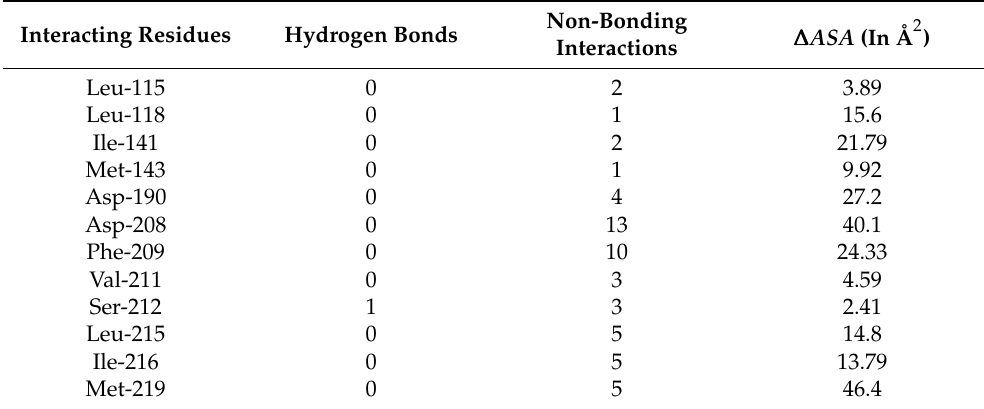
Table 4. The MEK1 residues interacting with selected flavonoid (CID: 10991656) are listed with the number of non-bonding interactions and ∆ ASA .